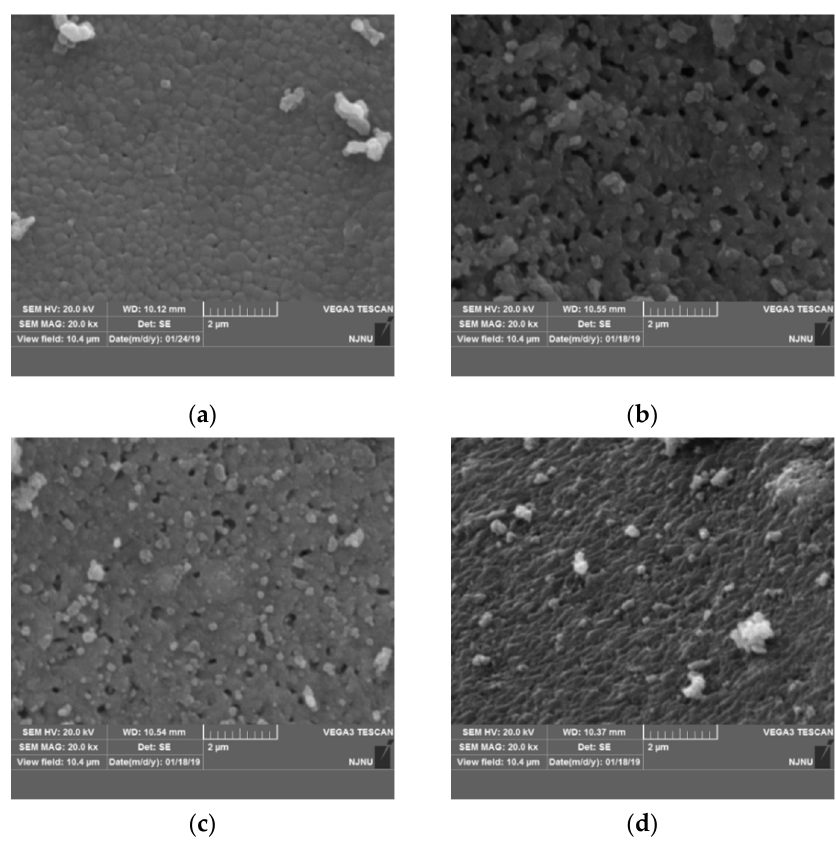
Figure 4. SEM images of Li 2 TiO 3 doped with different amounts of nickel at 750 °C. ( a ) 0% Ni; ( b ) 1% Ni; ( c ) 2% Ni; ( d ) 3% Ni.